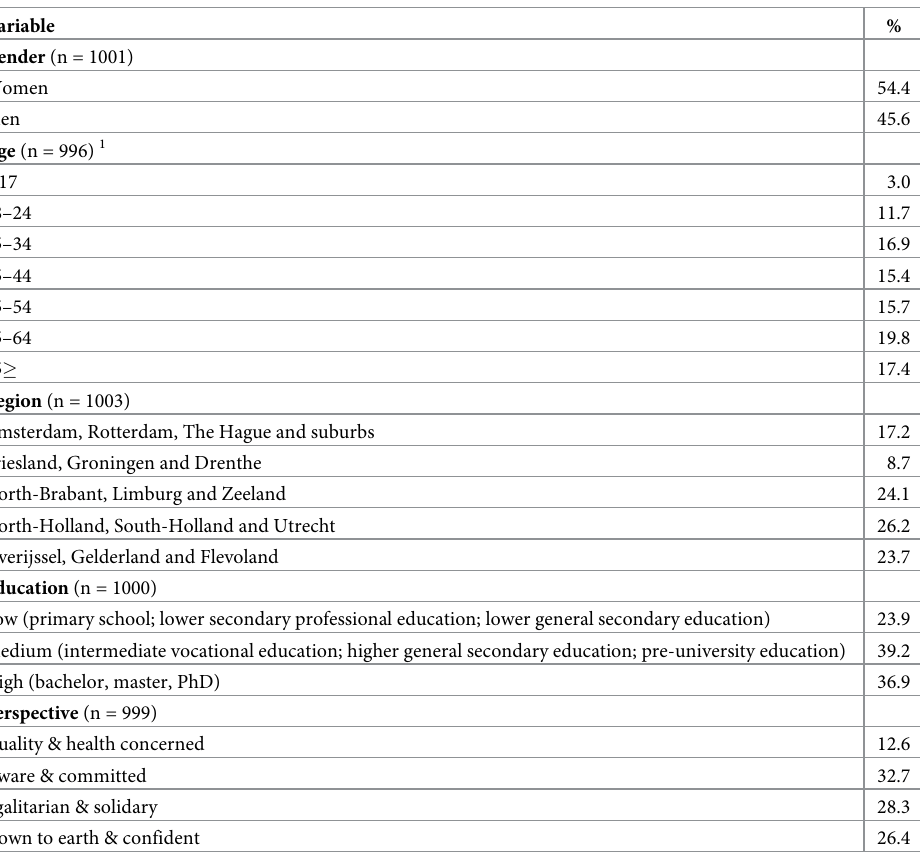
Table 2. Study sample